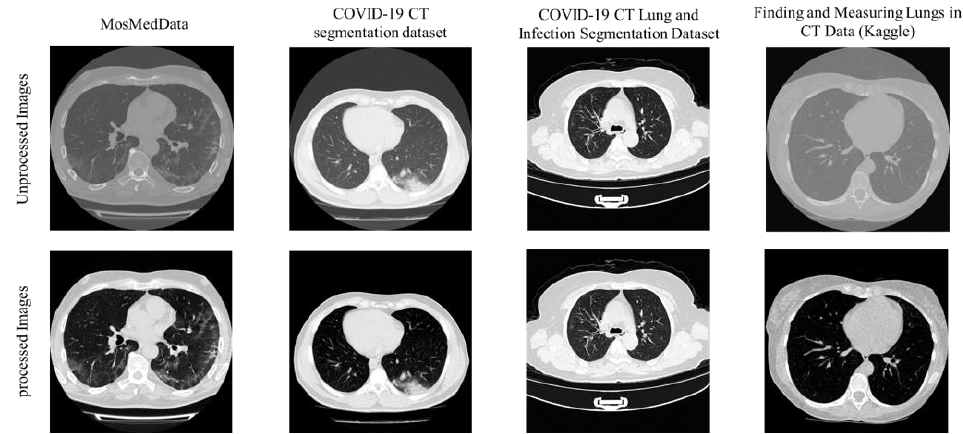
Figure 2. Sample of processed and unprocessed CT images used in this